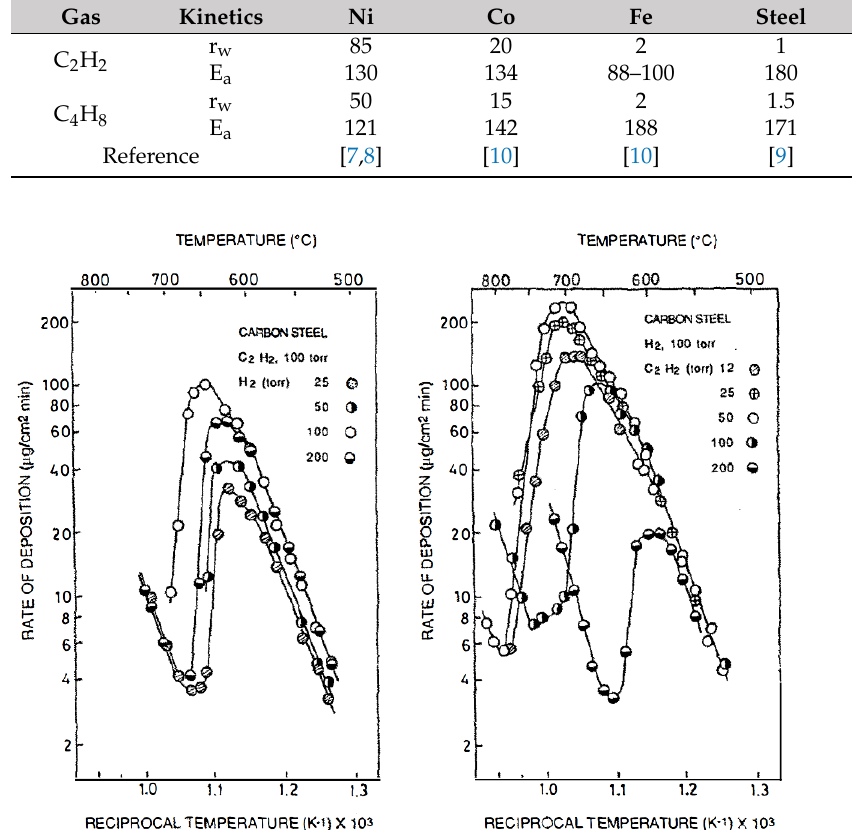
Figure 1. Arrhenius plots of the rates of carbon formation observed on steel from C 2 H 2 . (check also Figure 2). Reprinted from [9], with permission of Elsevier. Every point in the plot corresponds to a steady-state carbon deposition rate register (linearity) in a microbalance. This kinetic behavior was observed first on Ni in 1971 [7].